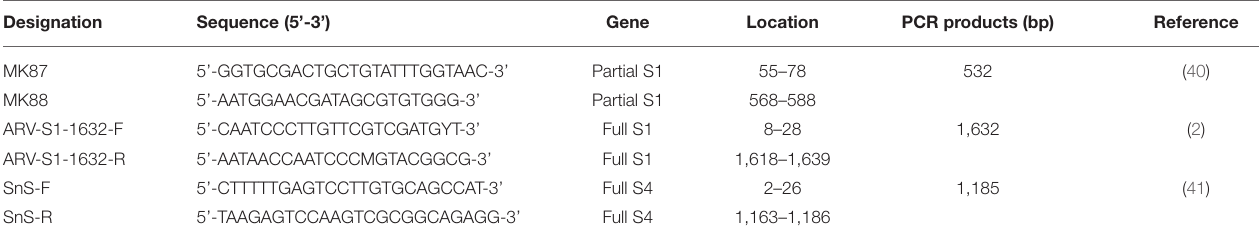
TABLE 1 | RT-PCR primer sequences and expected PCR